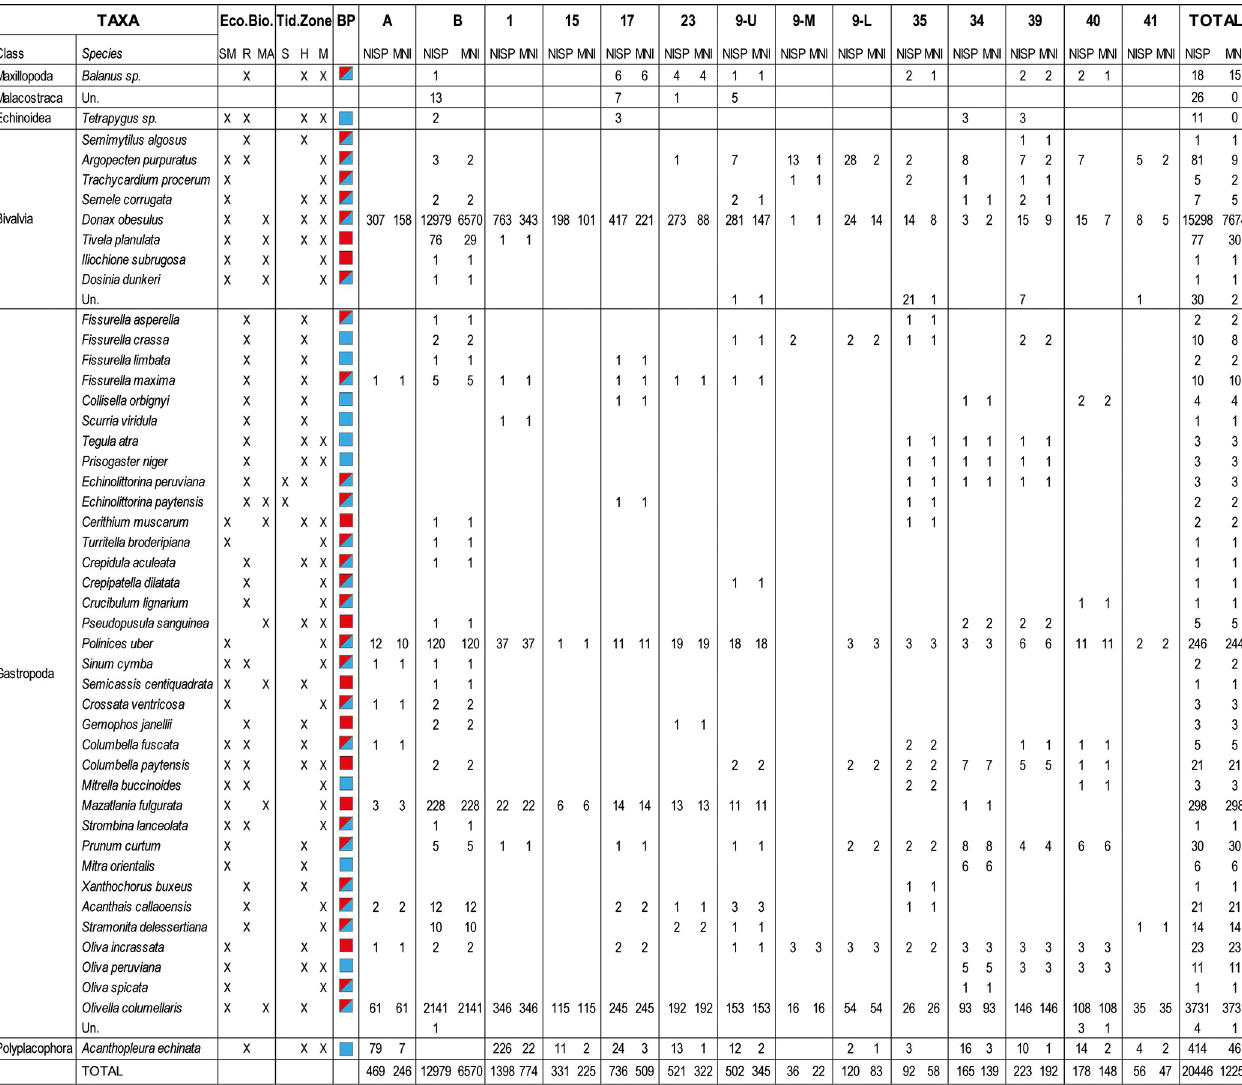
tion Zone; a blue square indicates that it lives in the Peruvian–Chilean Province. Eco. Bio. = ecological biotope; SM = sandy-muddy; R = rocky; MA = mangrove; Tid. Zone = tidal zone; S = spray zone; H = high-tide zone; M = middle tide zone; Un. = undetermined.